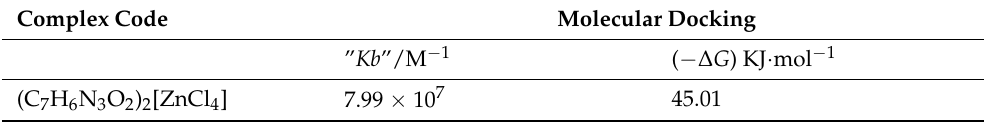
Table 3. Details of electronic descriptions calculated from molecular docking data.